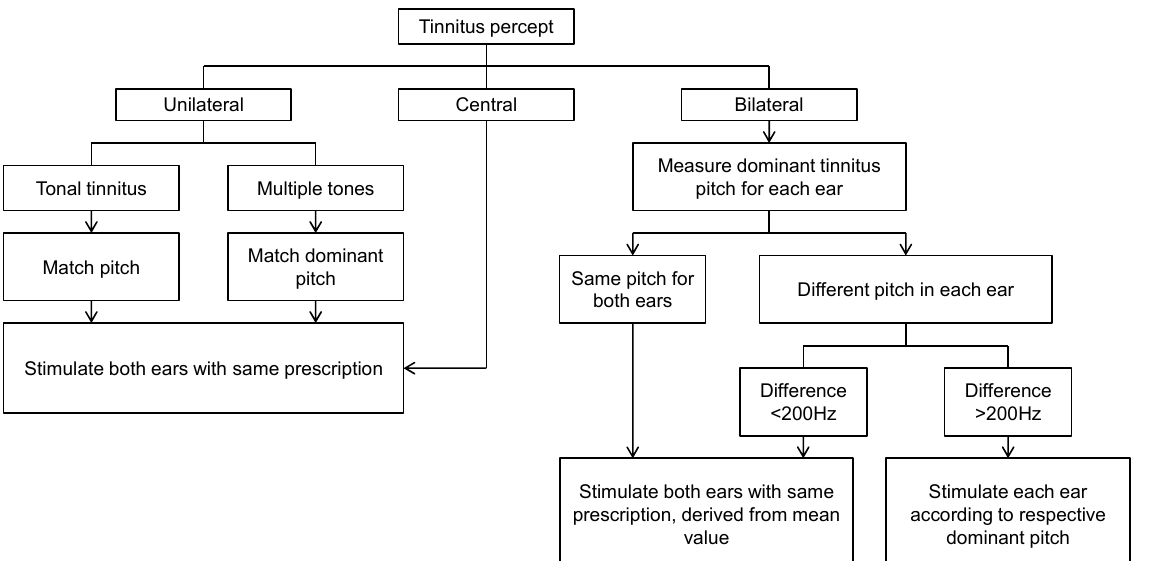
Figure 1. Overview of the T30 neurostimulator device fitting protocol used by the trial audiologists. A central tinnitus refers to a unified percept that is experienced in the head (not in the ear). In this case, only one ear needs to be assessed.